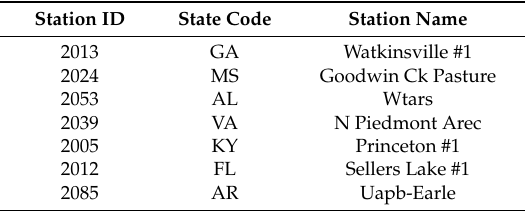
Table 2. Soil Climate Analysis Network (SCAN) stations used for